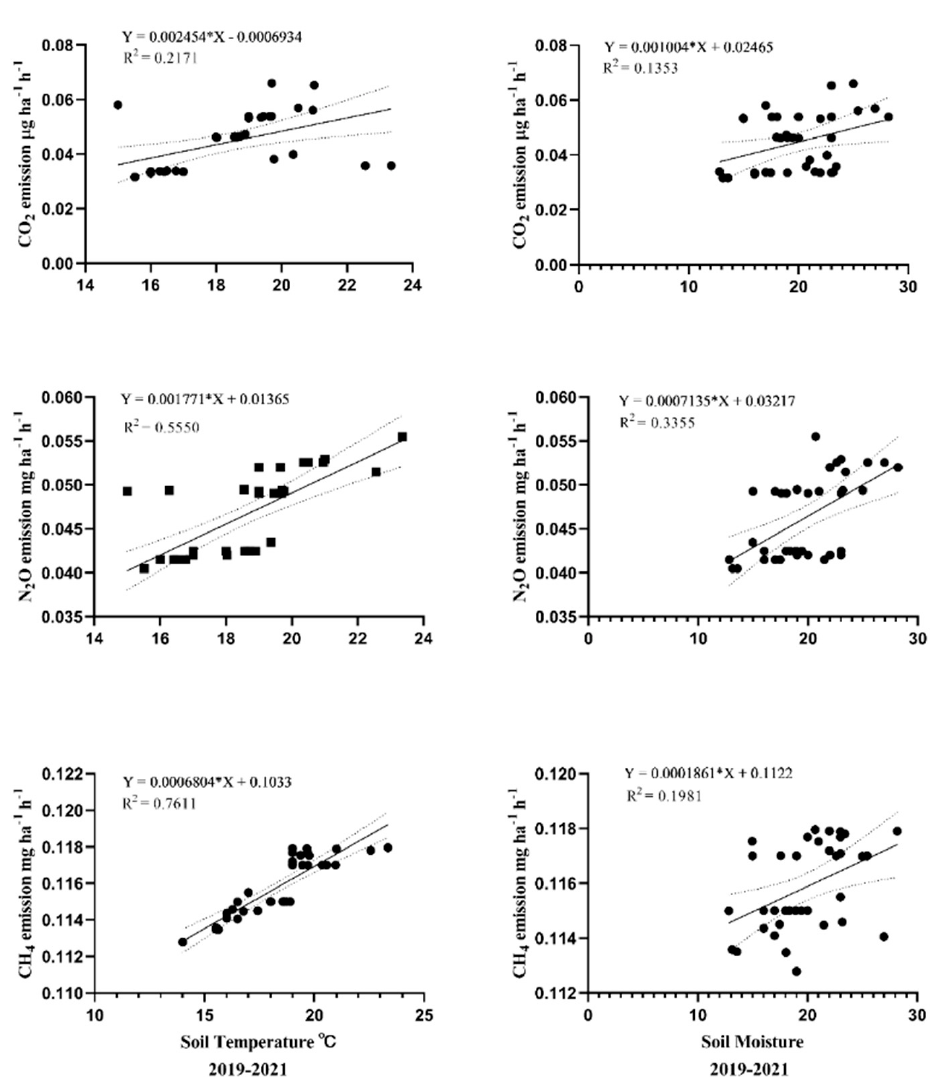
Figure 6. Linear relationship of soil CO 2 , N 2 O, and CH 4 emissions with soil temperature and soil moisture at different growth stages of spring barley (2020) and pea crops (2021).